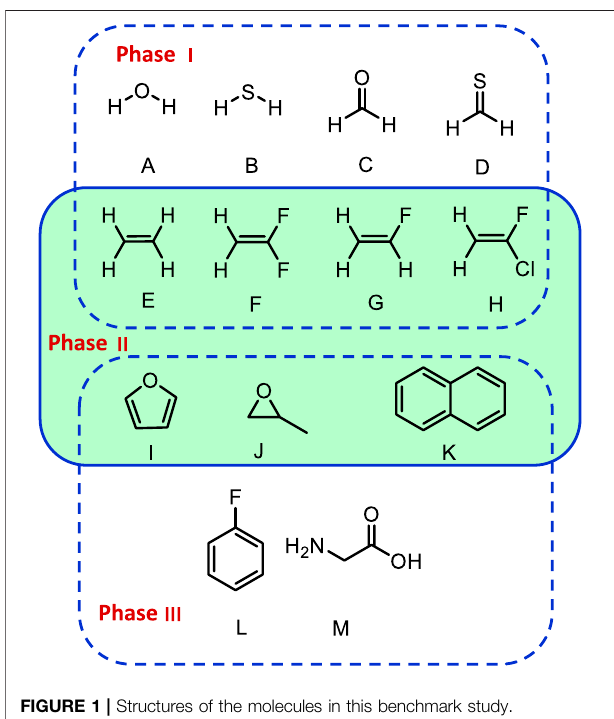
FIGURE 1 | Structures of the molecules in this benchmark study. (A) : Water, (B) : H 2 S, (C) : formaldehyde, (D) : thioformaldehyde, (E) : ethylene, (F) : 1,1-di fl uoroethylene, (G) : fl uoroethylene, (H) : 1- fl uoro-1-chloro-ethylene, (I) : furan, (J) : methyloxirane, (K) : naphthalene, (L) : 1- fl uorobenzene, (M) :